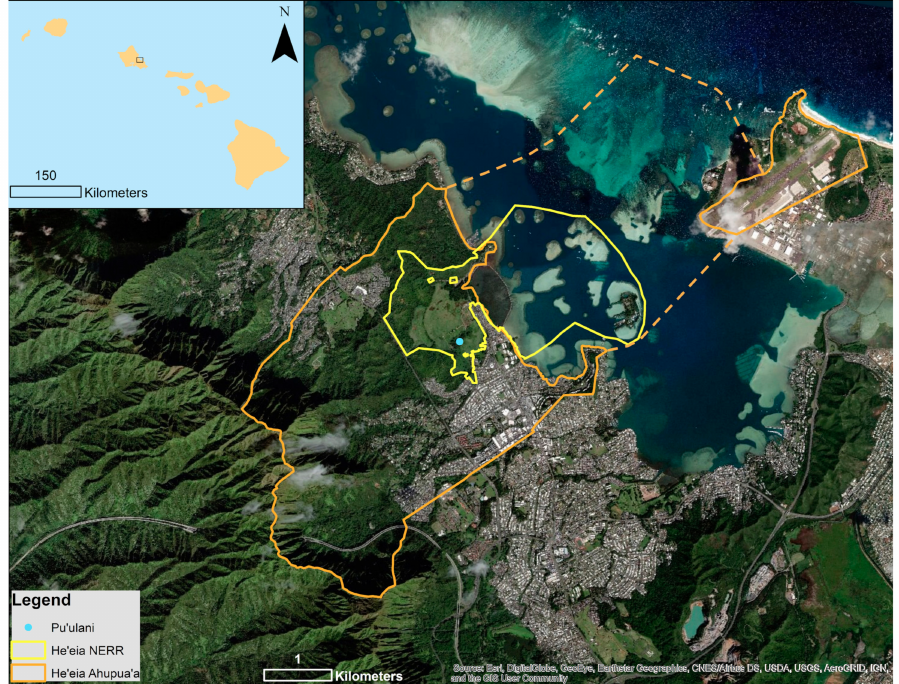
Figure 1. Pu‘ulani agroforestry restoration site, in the He‘eia ahupua‘a, Ko‘olaupoko, O‘ahu. Noted: solid orange line represents ahupua‘a boundaries in the Hawai‘i Statewide GIS Program Ahupua‘a GIS Layer. However, historical boundaries would have included the He‘eia fishery within the ahupua‘a boundaries and is approximately represented with the dashed orange lines following the ahupua‘a of He‘eia land commission award (Ahupua‘a of He’eia and its appurtenant Fishery, L.C.Aw.10613, Ap.1 to A. Paki. From: Public archives of Hawai’i, Letter Folder